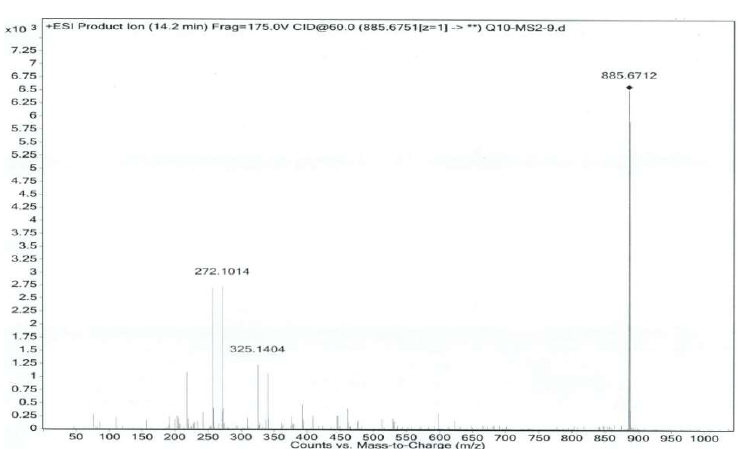
Figure 4. MS spectrum of Co-Q10 reference substance.